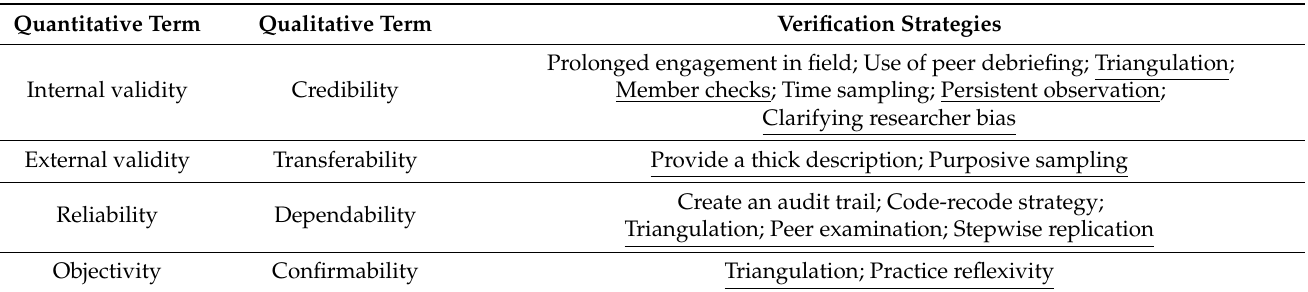
Table 1. Assignment of the quality criteria in quantitative and qualitative terms as well as